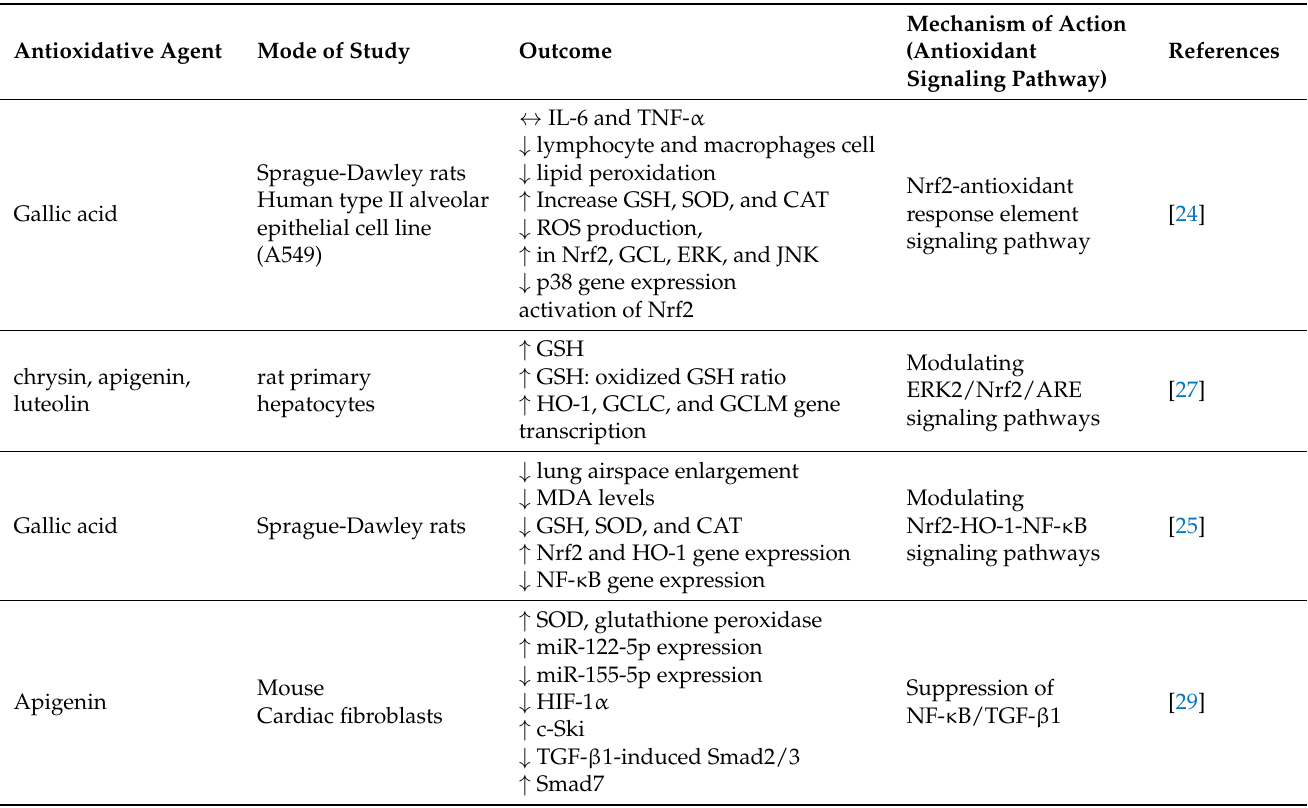
Table 1. Antioxidant signaling pathways of phenolic acids and